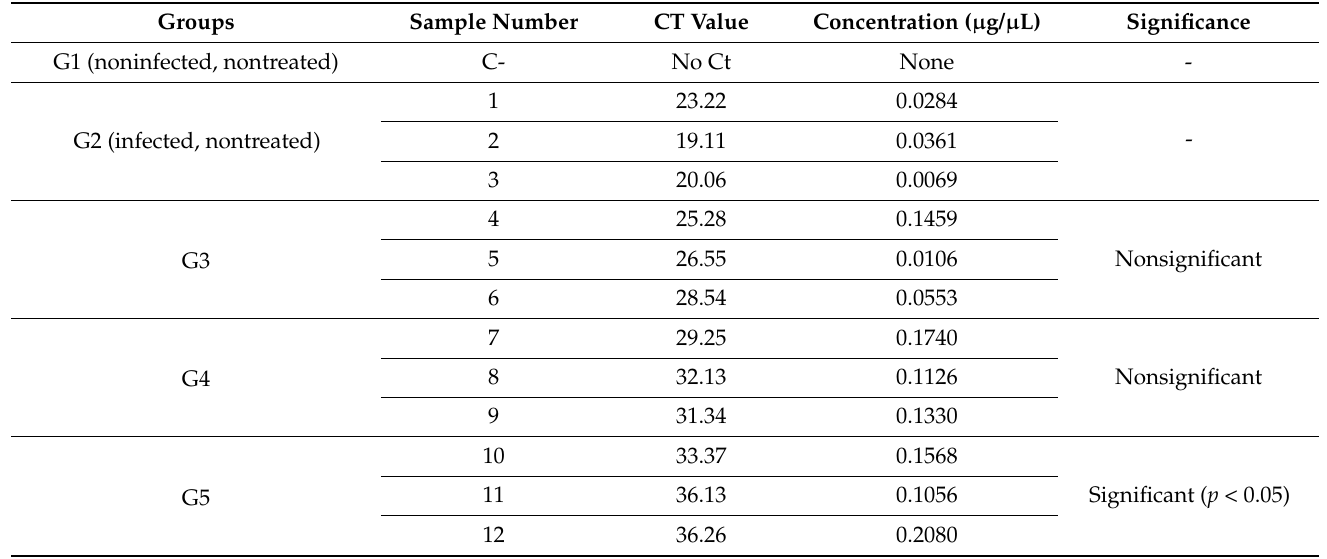
Table 2. Mean CT value and concentration of the parasite in the liver tissues of experimental